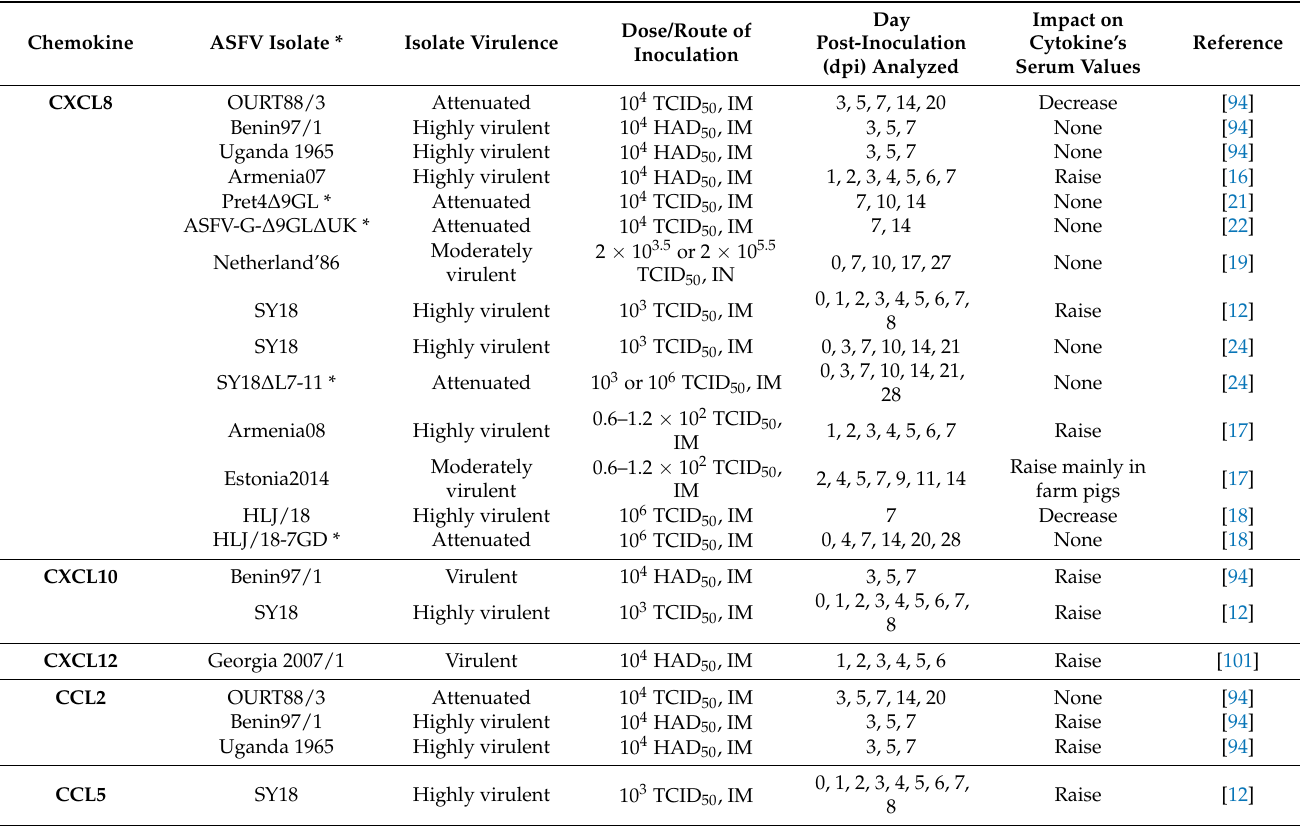
Table 4. Modulation of circulating levels of chemokines in domestic pigs infected with ASFV isolates of diverse